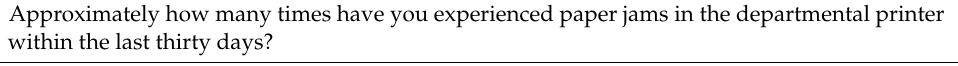
Table 1. Cont. Access to Facilities, Infrastructure, and